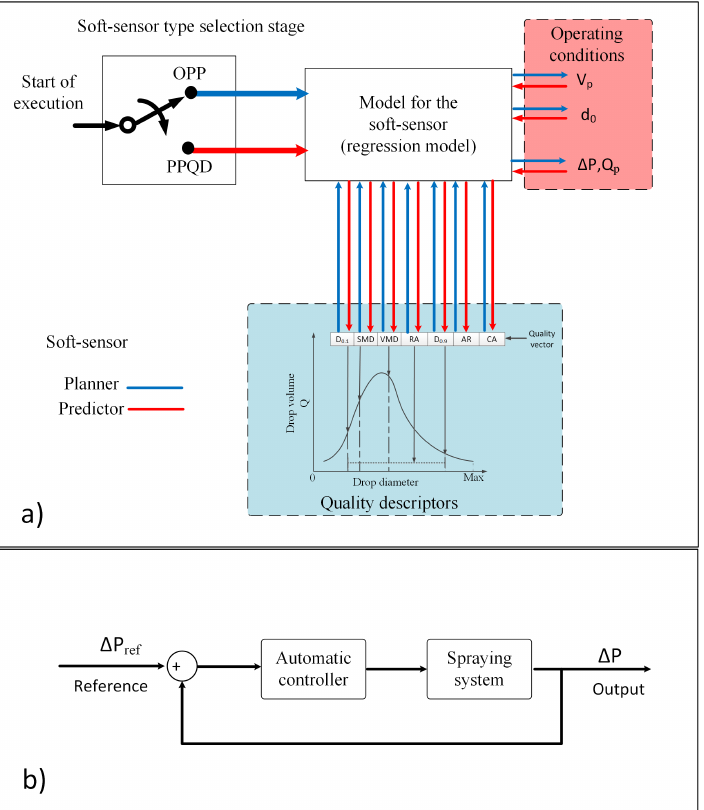
Figure 1. ( a ) Architecture of the soft sensor used as a predictor for the variables of the quality descriptors (red arrows) or operation planner of the agricultural spraying process (blue arrows). ( b ) Automatic system for the sprayer boom